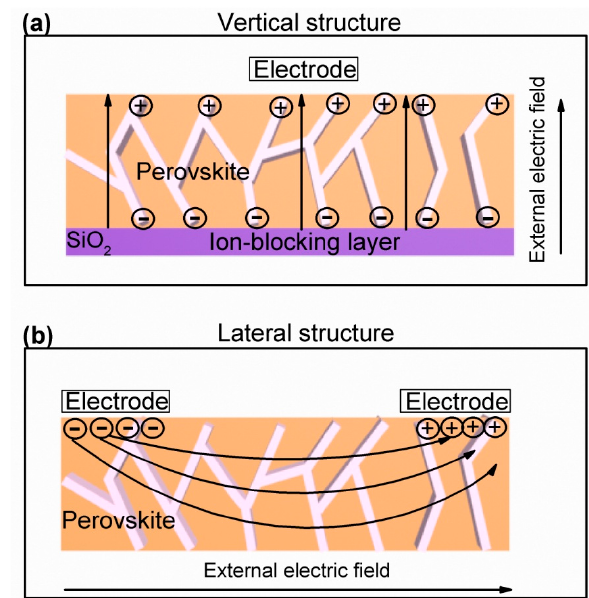
Figure 3. The schematic diagram of ion migration paths: ( a ) vertical structure; ( b ) lateral structure.